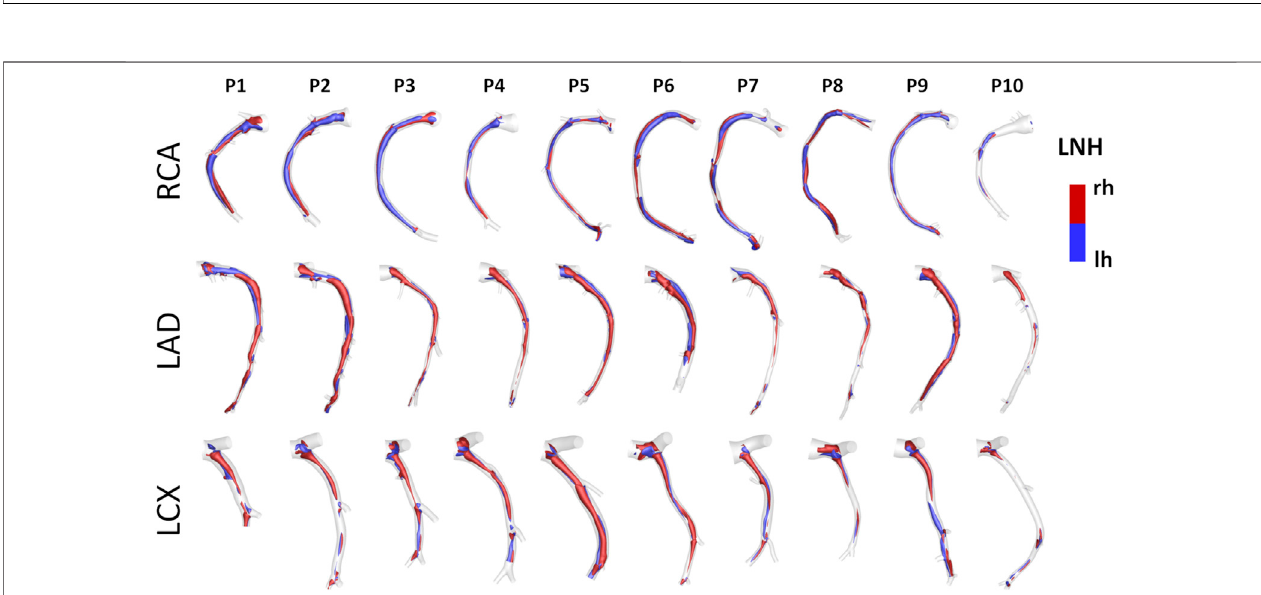
FIGURE 6 | Intravascular fl uid structures in the 30 swine coronary arteries. For each case, isosurfaces of cycle-average LNH are presented. Distinguishable left- handed (lh - LNH < 0) and right-handed (rh - LNH > 0) helical fl ow structures can be observed in all coronary arteries. Labels from P1 to P10 identify the single pig. Right (RCA), left anterior descending (LAD), and left circum fl ex (LCX) coronary artery geometries are grouped.